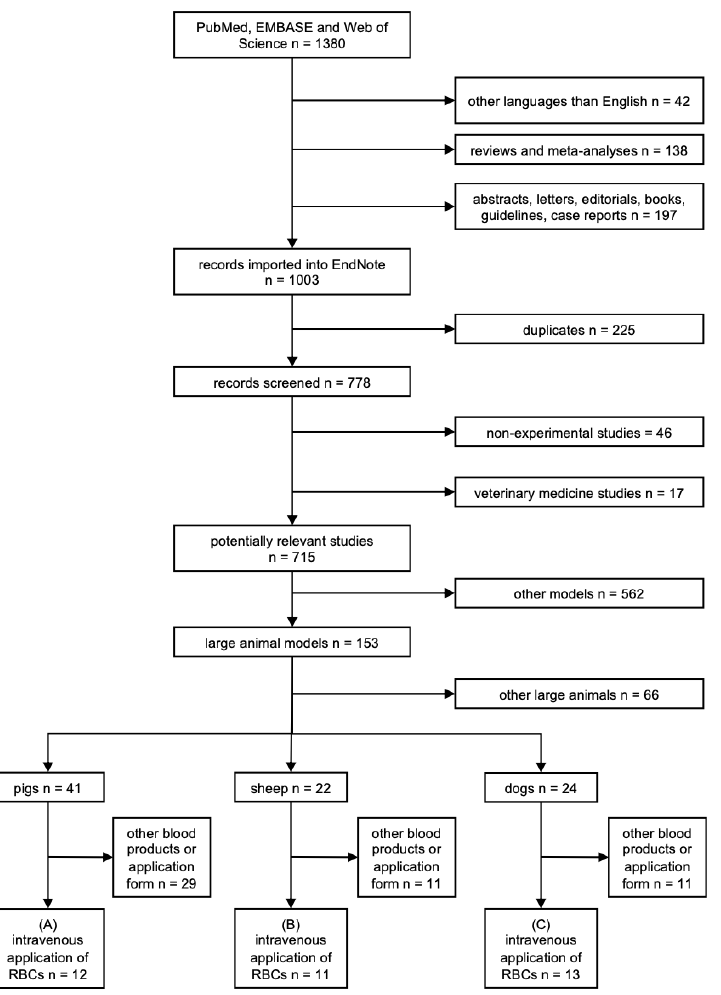
Figure 1. Study flow diagram. PubMed: Public Medicine, EMBASE: Excerpta Medica dataBASE, RBCs: red blood cell concentrates.